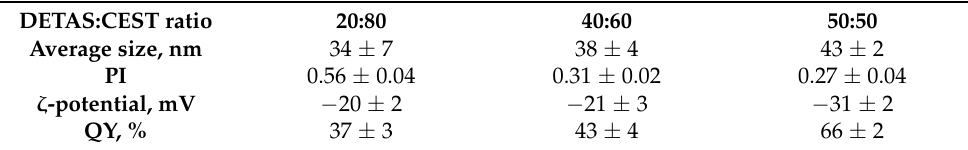
Table 2. Morphological, electrokinetic, and QY values of obtained composites from CA and silica nanoparticles with different DETAS:CEST